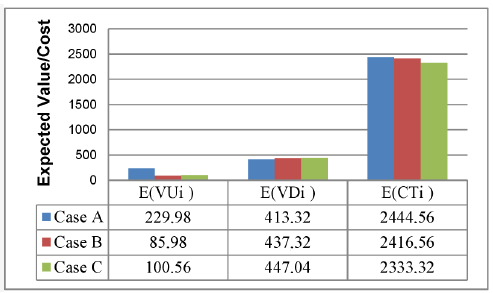
Fig. 6. Results of modelling the three cases